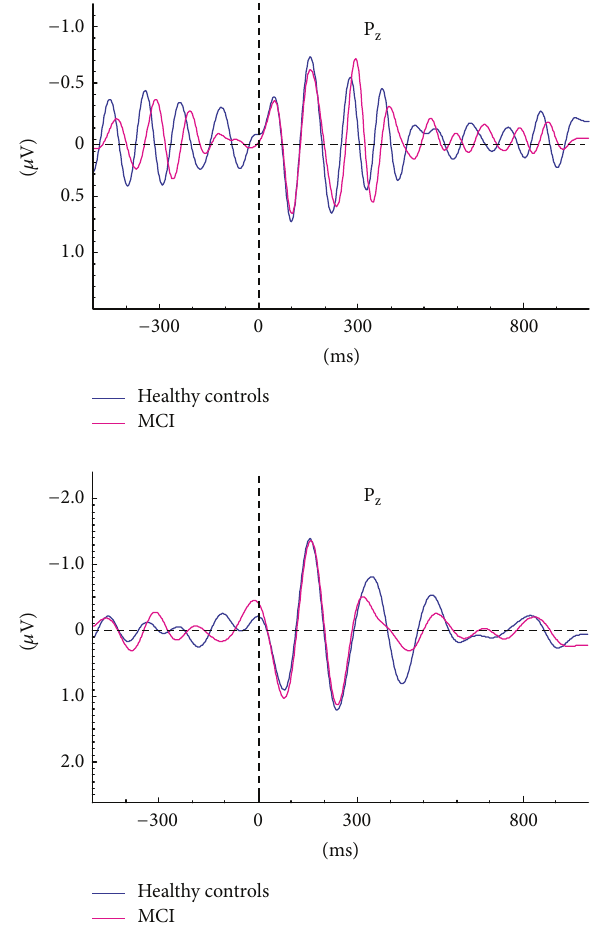
Figure 5: Grand averages of alpha (8–13 Hz) and theta (4–7Hz) oscillatory responses of healthy control subjects ( 𝑛 = 22 ) and MCI ( 𝑛 = 21 )